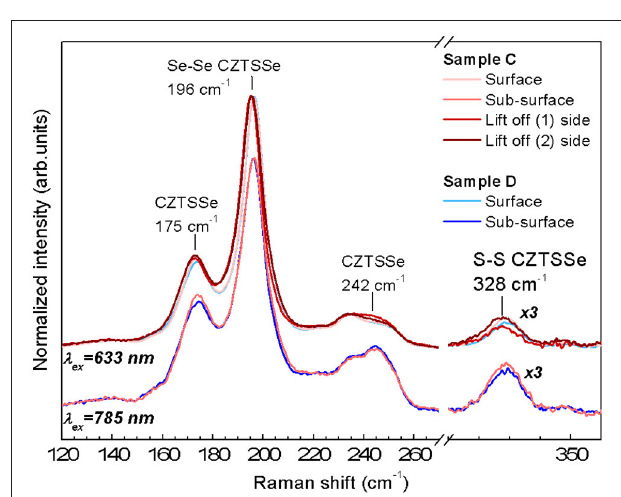
FIGURE 4 | Raman spectra of the samples C and D acquired under 633 and 785nm wavelengths (corresponding to different penetration depths, thus surface and sub-surface regions) and from the bulk of the absorber layer after lift-off process. (1) And (2) sides are the Raman spectra obtained at the regions (1) and (2) indicated in Figure 2B . The region centered at 330 cm − 1 has been magnified x3 to clarify the contribution S-S vibration that indicates the S presence in the kesterite